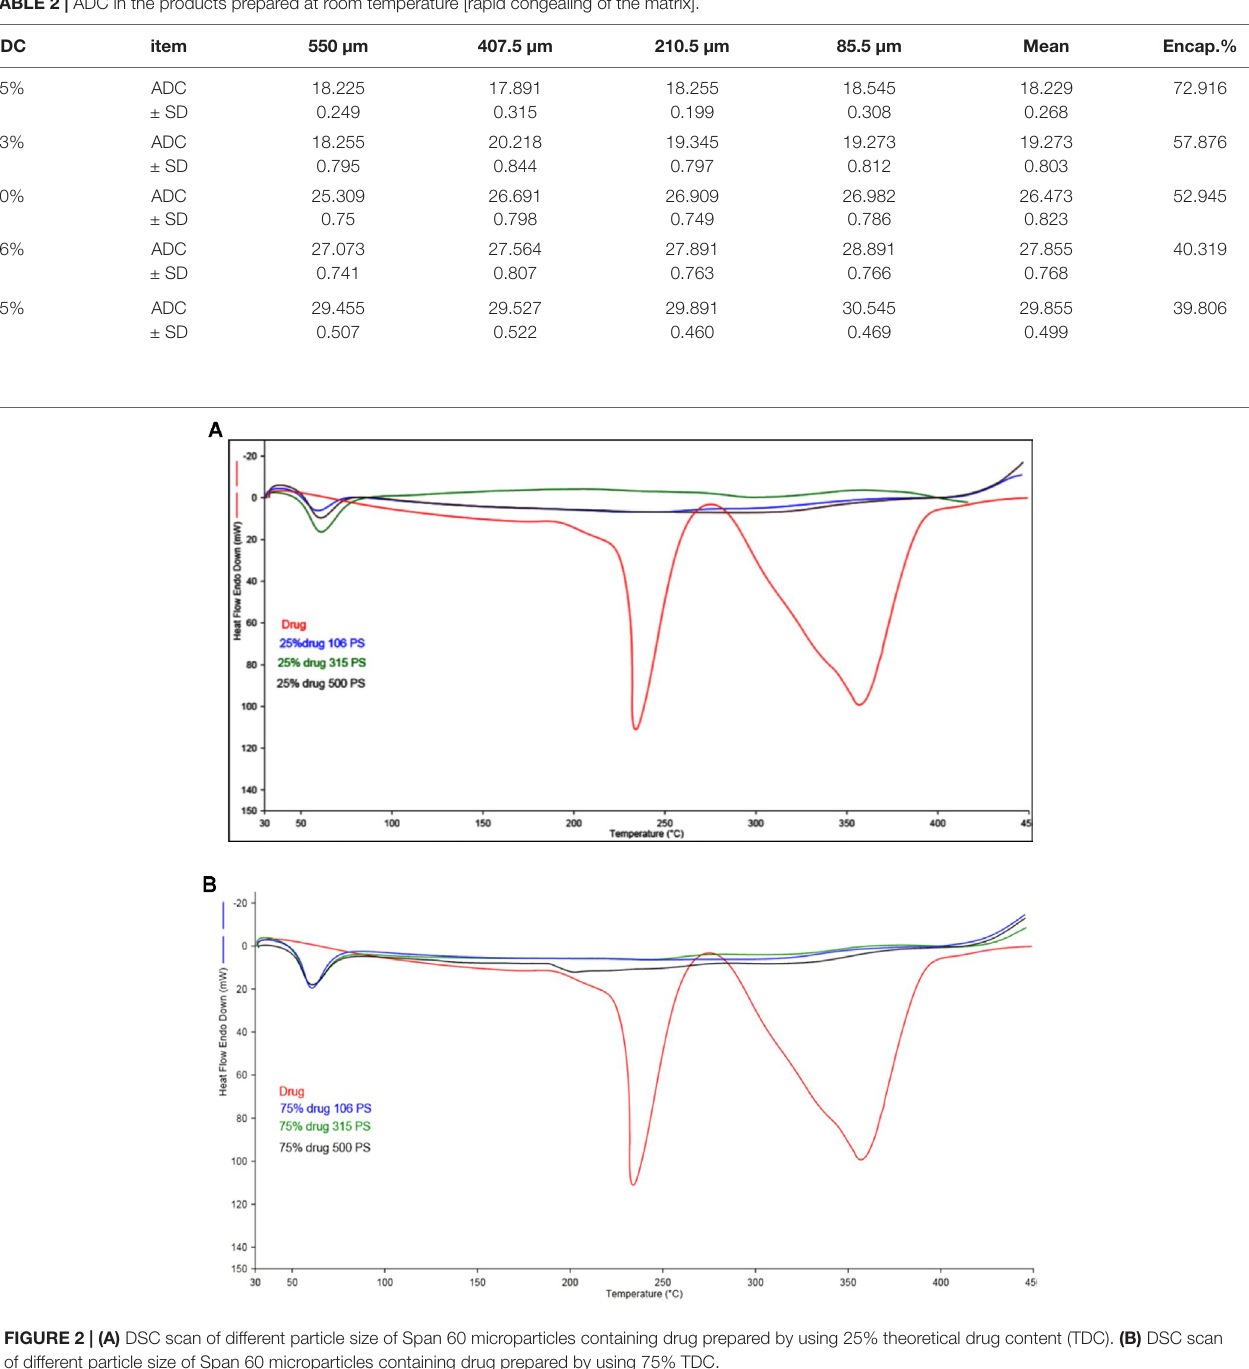
TABLE 2 | ADC in the products prepared at room temperature [rapid congealing of the matrix].